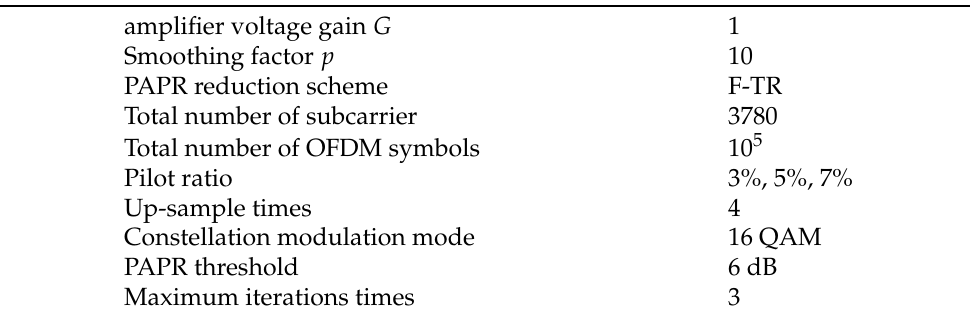
Table 1. Simulations parameters of Simulation